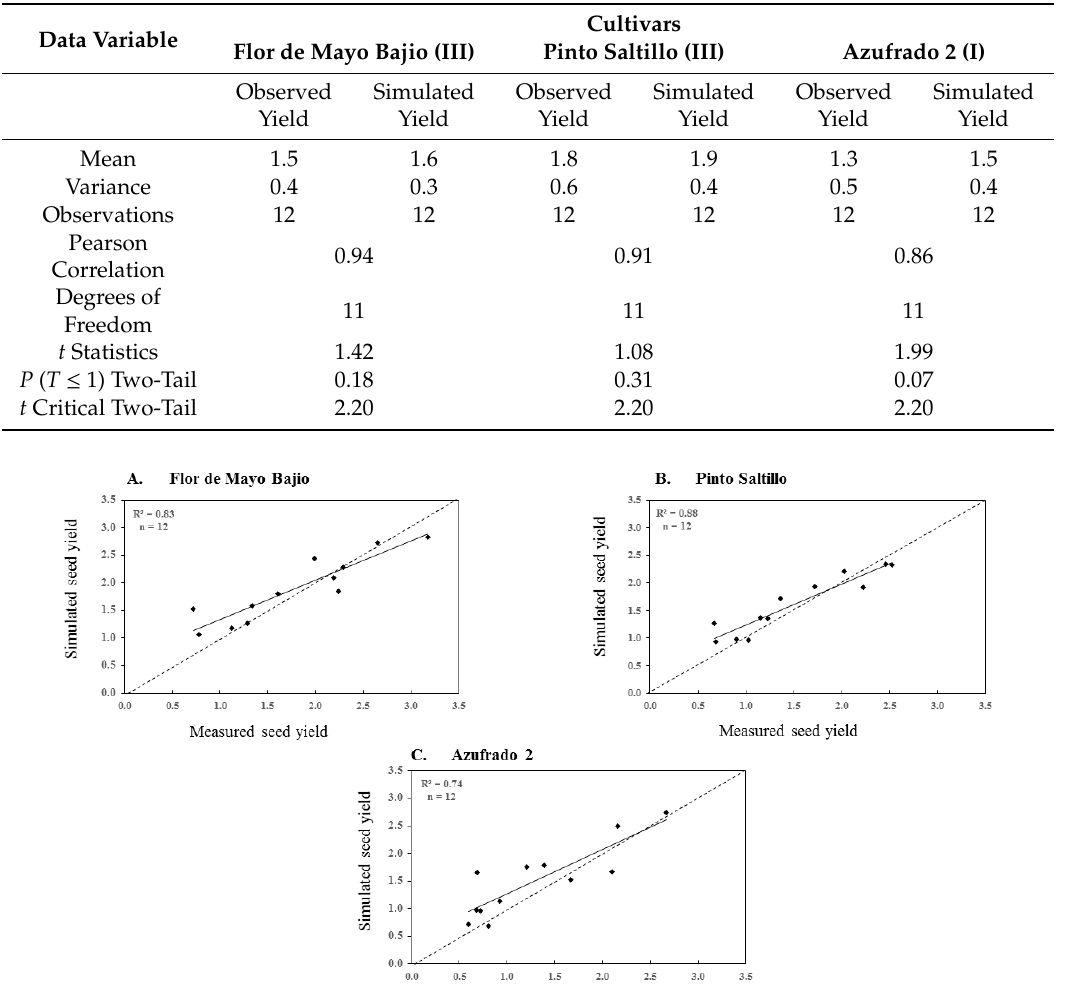
Table 4. Paired t -test statistics to assess differences between observed and simulated seed yield (Mg ha − 1 ) of common bean cultivars growth habit III and I sown under rainfed conditions in Mexican semi-arid temperate highlands.